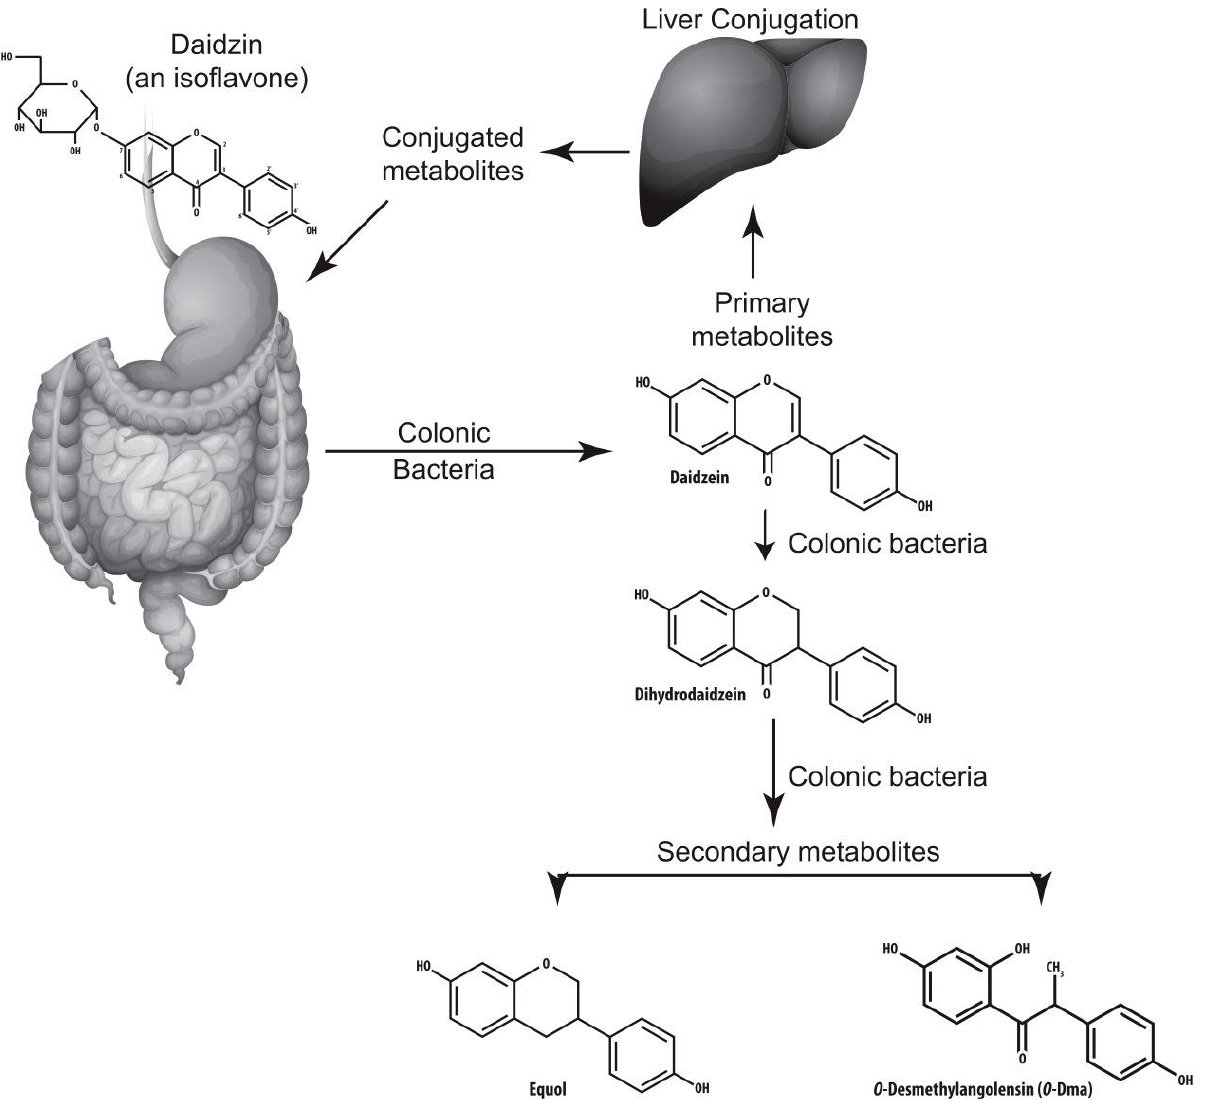
Figure 1. Illustration of the role of colonic bacteria in the production of primary and secondary metabolites from the isoflavone daidzin and in the metabolism and circulation of daidzein liver conjugates. Whereas the intestinal microflora produces ( S )-equol from daidzein, the O -desmethylangolensin (DMA) produced as the result of intestinal bacterial activities is ( R )- O